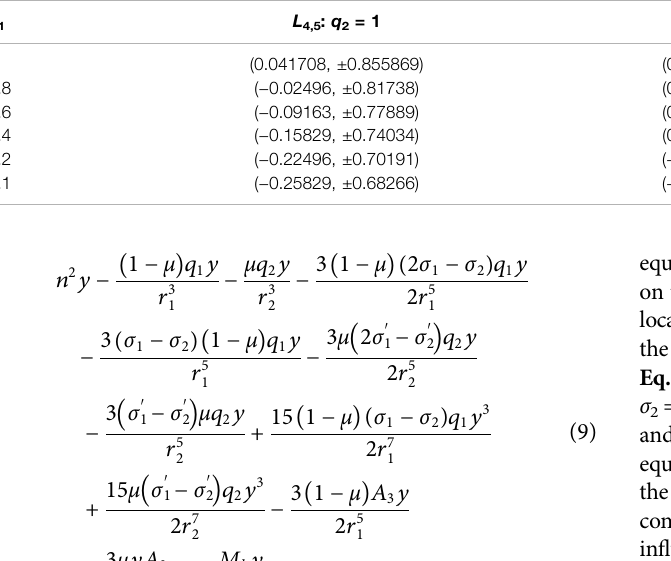
TABLE 5 | Positions ( x 0 , ± y 0 ) of the triangular points of the binary HD155876 system for three fi xed values of q 2 when q 1 radiates. The disc, oblateness, and triaxiality parameters are kept as constants as in the collinear case (Table 4)